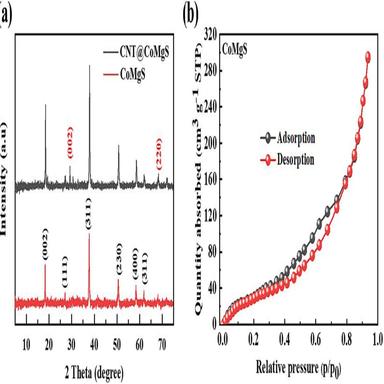
(a) XRD spectra of CoMgS and CNT@CoMgS, (b) BET examination of adsorption/desorption isotherm curves of CoMgS.